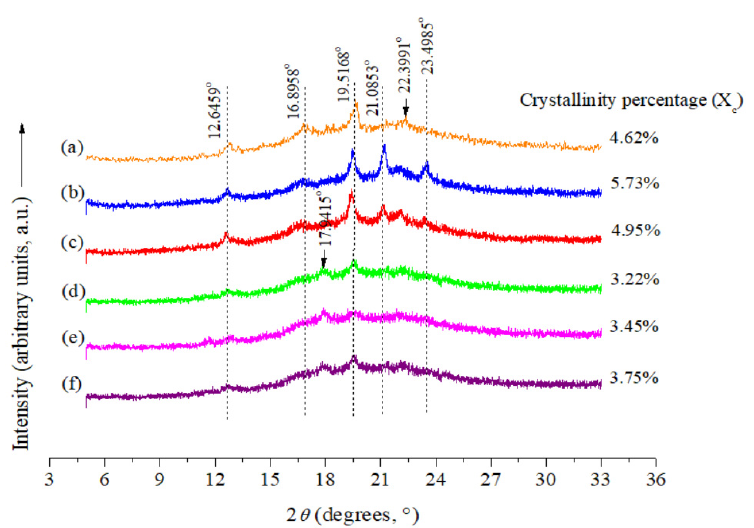
Figure 4. XRD patterns from the different spaghetti-type pasta systems studied: ( a ) NSt, ( b ) NSt + Bu, Figure 4. XRD pa tt erns from the di ff erent spaghe tt i-type pasta systems studied: ( a ) NSt, ( b ) NSt + ( c ) NSt + Bu + TAc, ( d ) OSt, ( e ) OSt + Bu and ( f ) OSt + Bu + Bu, ( c ) NSt + Bu + TAc, ( d ) OSt, ( e ) OSt + Bu and ( f ) OSt + Bu + TAc.